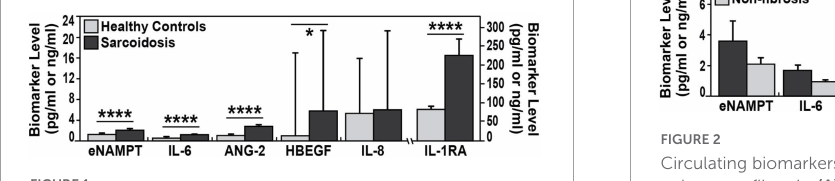
FIGURE1 Biomarker plasma levels in sarcoidosis and healthy controls. Plasma levels medians are plotted. Compared to healthy controls, each biomarker exhibited higher values in plasma of sarcoidosis patients. Except for IL-8 all of plasma biomarkers were significantly higher in sarcoidosis. eNAMPT (2.1 vs. 1.2 ng/ml), IL-6 (1.2 vs. 0.6 pg/ml), ANG-2 (2.7 vs. 1.0 pg/ml), HBEGF (5.9 vs. 1 pg/ml), and IL-1 RA (227 vs. 82.3